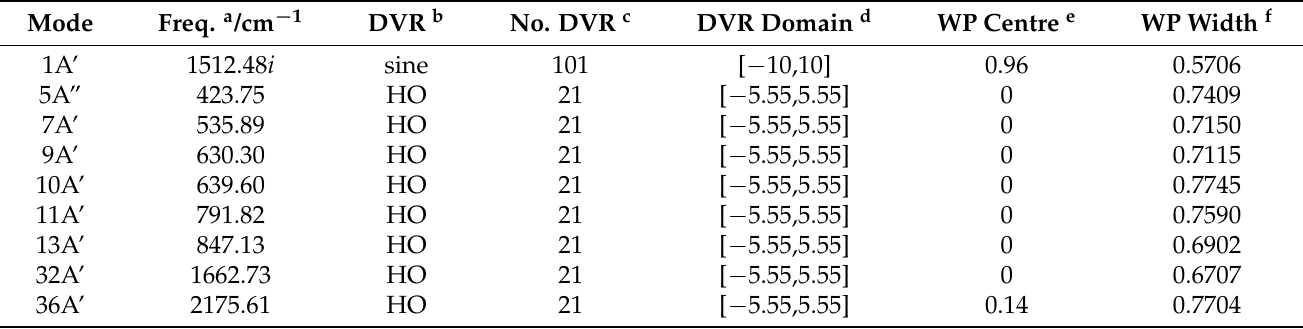
Table 1. Details of the normal modes, discrete variable representation (DVR) bases and initial wavepacket conditions used in the salicylaldimine calculations. ( a ) Frequencies of the normal modes calculated at the proton transfer transition state. Ref. [67] ( b ) Type of underlying basis functions used to generate the DVR bases: sine denotes eigenfunctions of the 1D particle-in-a-box and HO refers to the eigenfunctions of the harmonic oscillator problem. ( c ) The number of DVR gridpoints for each mode. ( d ) Locations of the initial and final DVR gridpoints along each mode. Note that the sine DVR gridpoints are evenly spaced whilst the HO points are not, being more concentrated towards the origin. ( e ) Coordinate of the centre of the initial wavepacket. ( f ) Width of the initial